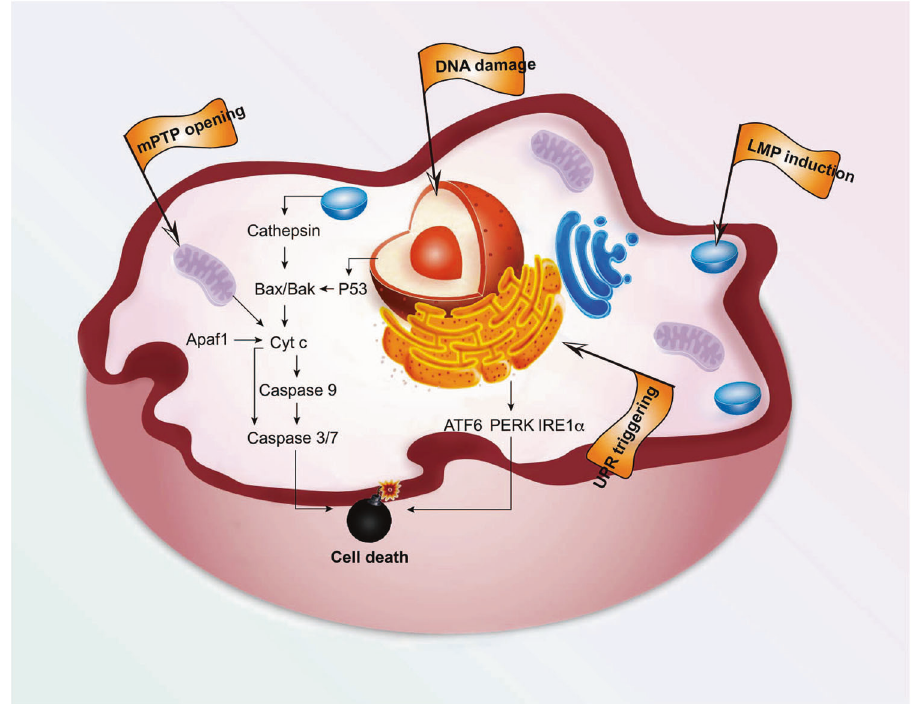
Fig. 1 Organelle-targeted therapy boosts cancer treatment outcomes by allowing for maximum accumulation of therapeutic agents in targets, triggering speci fi c cell death